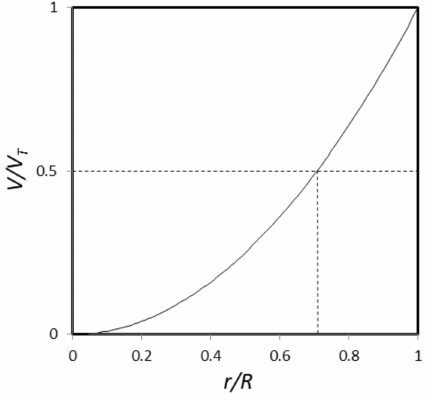
Figure 4. Plot of dimensionless volume ( V / V T ) versus dimensionless radius ( r / R